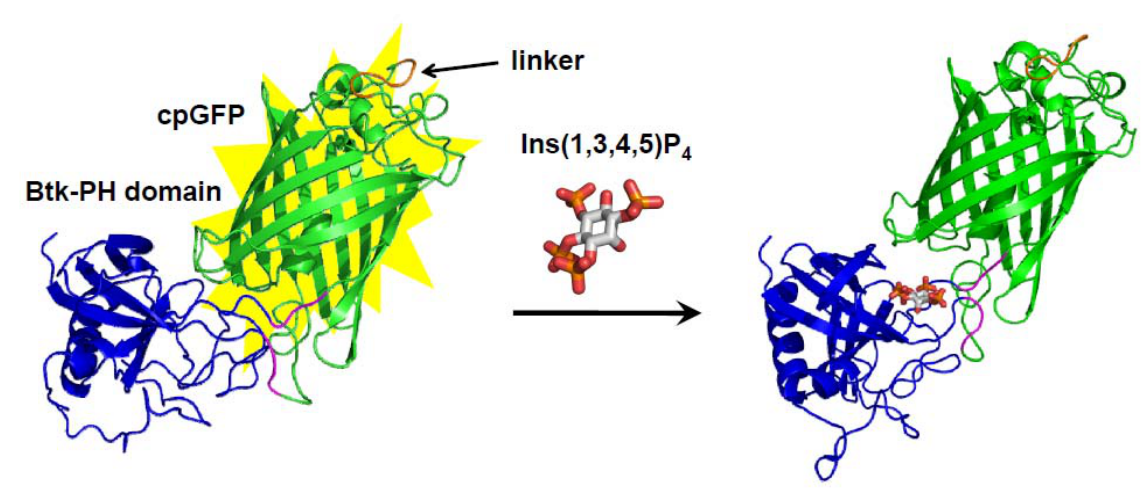
Figure 2. Schematic illustration shows a fluorescent biosensor for inositol tetrakisphosphate based on the split Btk PH domain-cpGFP conjugate [56]. The original N and C termini are linked with a short peptide linker (orange), and the novel terminal of cpGFP (purple) is fused to the split Btk PH domain (blue). The conformational change of the PH domain induced by the ligand-binding event was transduced to the structural perturbation at the chromophore of conjugated GFP, and then resulted in the ratiometric fluorescence change of